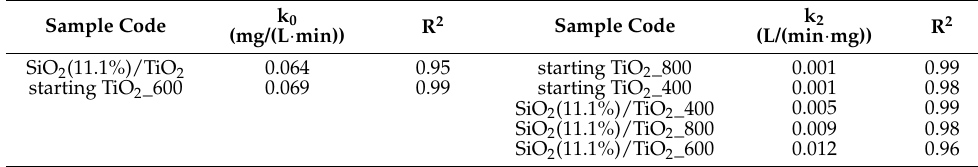
Table 5. The fitting parameters, zero and pseudo-second reaction rate constants for methylene blue decomposition (after 5 h of VIS